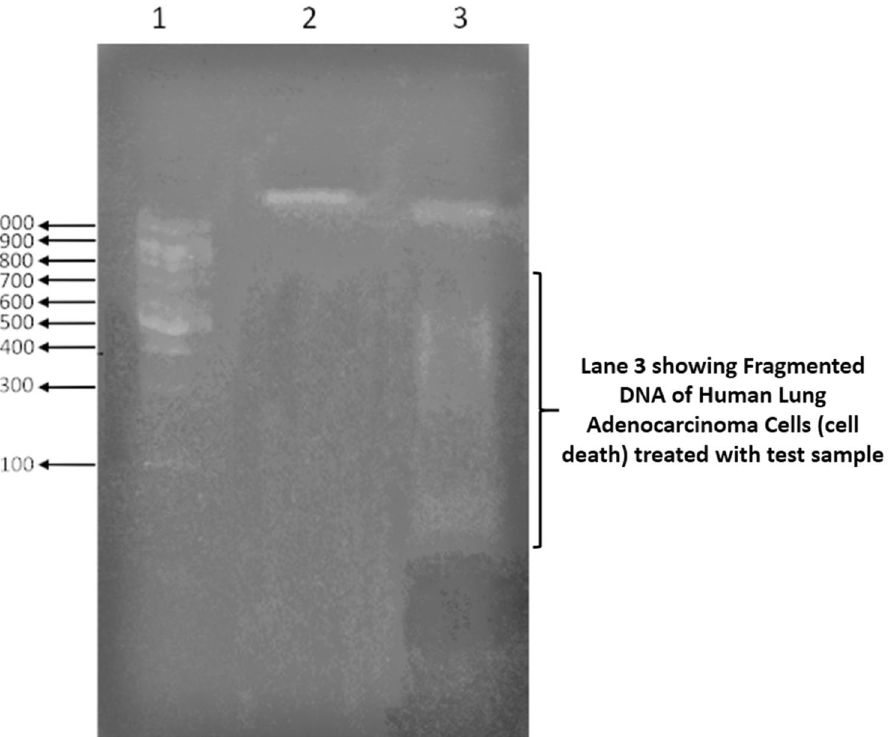
Figure 15. DNA Fragmentation assay; Lane 1: DNA ladder; Lane 2: Human Lung Adenocarcinoma Control Cells showing single DNA band; Lane 3: Human Lung Adenocarcinoma Cells treated with test sample showing fragmented